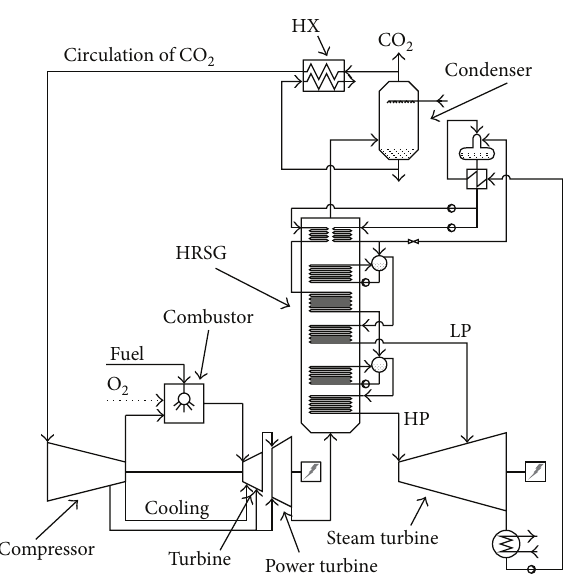
Figure 2: Schematic layout of the